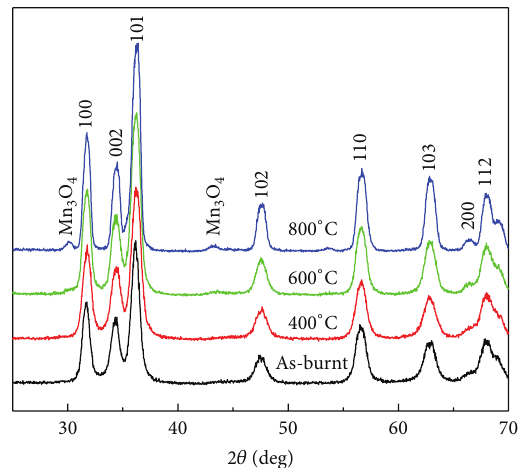
Figure 1: XRD spectra of as-burnt and annealed nanostructures of Zn 0.95 Mn 0.05